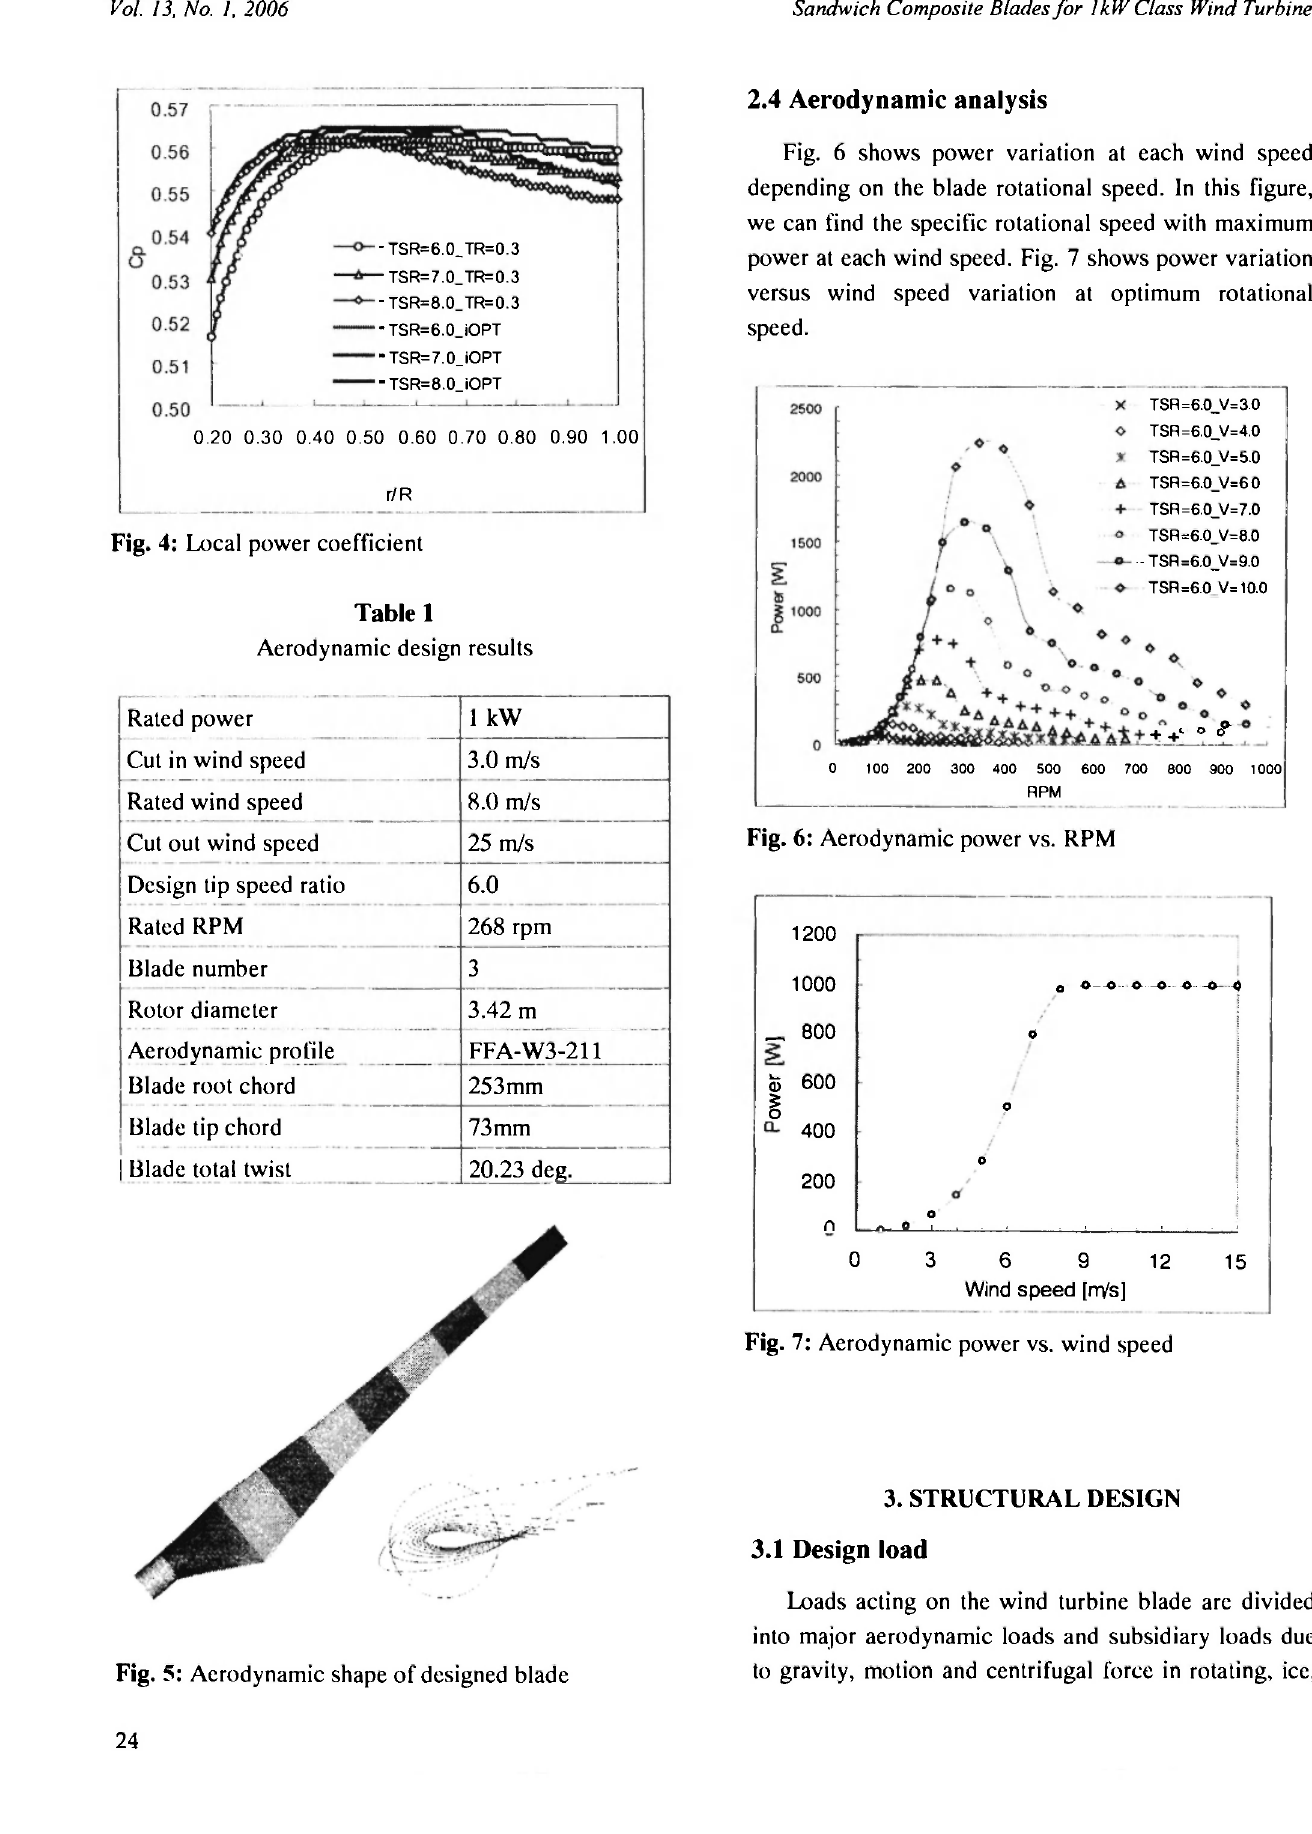
Fig. 7: Aerodynamic power vs. wind